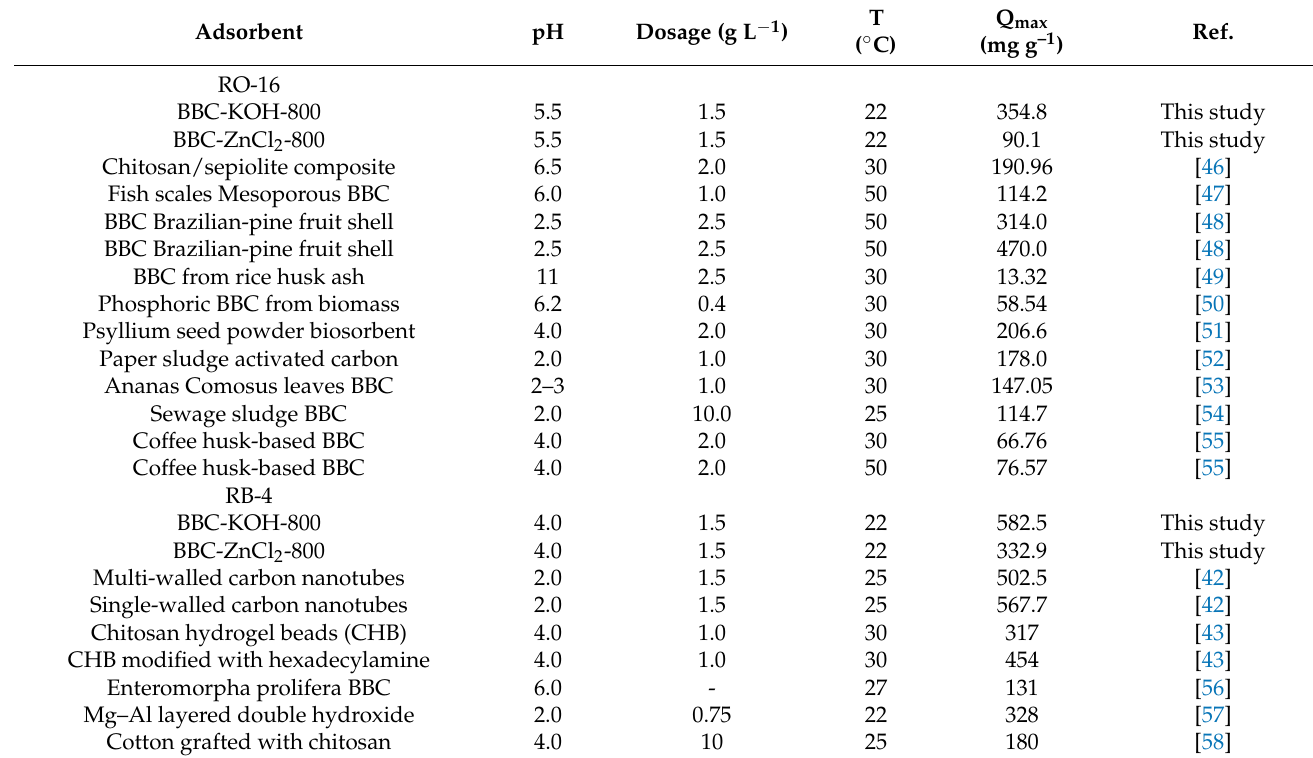
Table 7. Comparison of KOH-BBC and ZnCl2-BBC concerning the reported literature in terms of capacity.